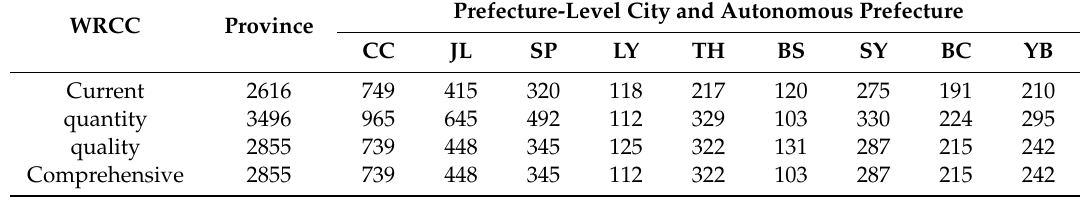
Table 4. The water resources carrying capacity (WRCC) of Jilin 10,000 people.